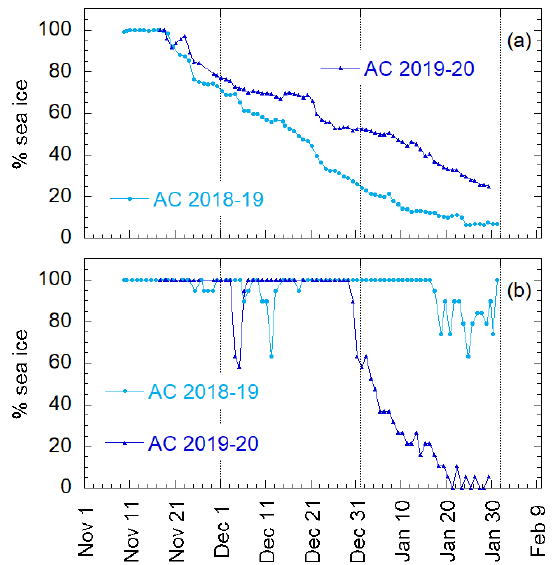
Figure 4. Percentage of the area covered by sea ice for the (a) Ross Sea (800 × 800km 2 ) and (b) the restricted area of polynya in the Ross Sea (100 × 100km 2 ) for the two